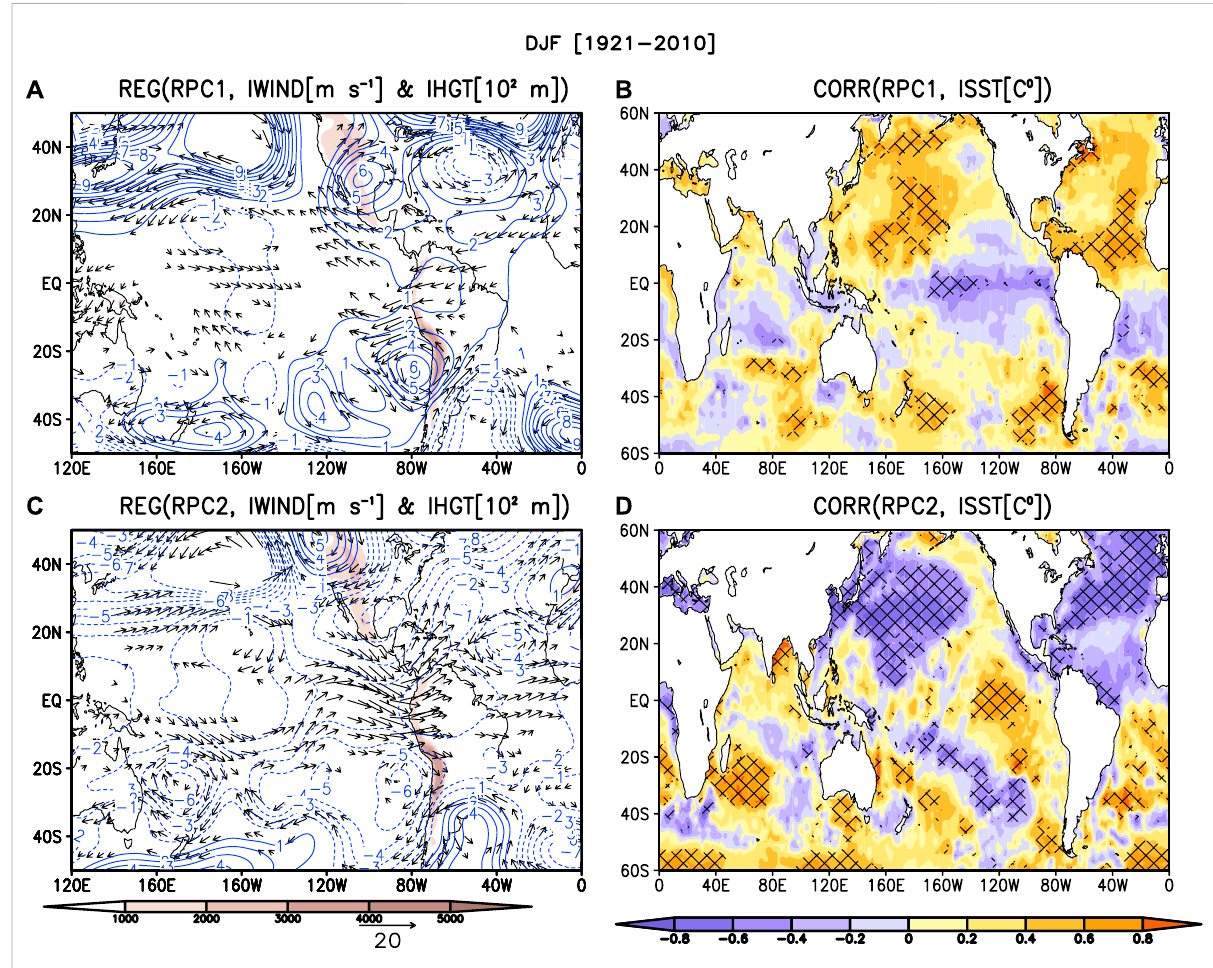
FIGURE 11 Linear regression coef fi cients between theinterdecadal component of the DJF wind and geopotential height anomalies over South America at 200 hPa and (A) the fi rst rotated principal component of the interdecadal variability of the DJF precipitation (RPC1) over the Central Andes. (C) As in (A) but for the second rotated principal component of the interdecadal variability of the DJF precipitation (RPC2). Values are in m s − 1 and 100 m for one standard deviation of each corresponding RPC. The contours of geopotential height anomalies equal to zero were omitted and negative contours are dashed. Black vectors have zonal and meridional wind components statistically signi fi cant at the 95% con fi dence level. Andes topography above 1,000 m is indicated by brown shading. The analysis based on the ERA-20C reanalysis. (B,D) Correlation coef fi cients between RPC1 and RPC2 and the interdecadal component of the DJF global SST for the 1921 – 2010 period. Hatching represents a statistically signi fi cant correlation at the 95% con fi dence level. The analysis covers the 1921 – 2010